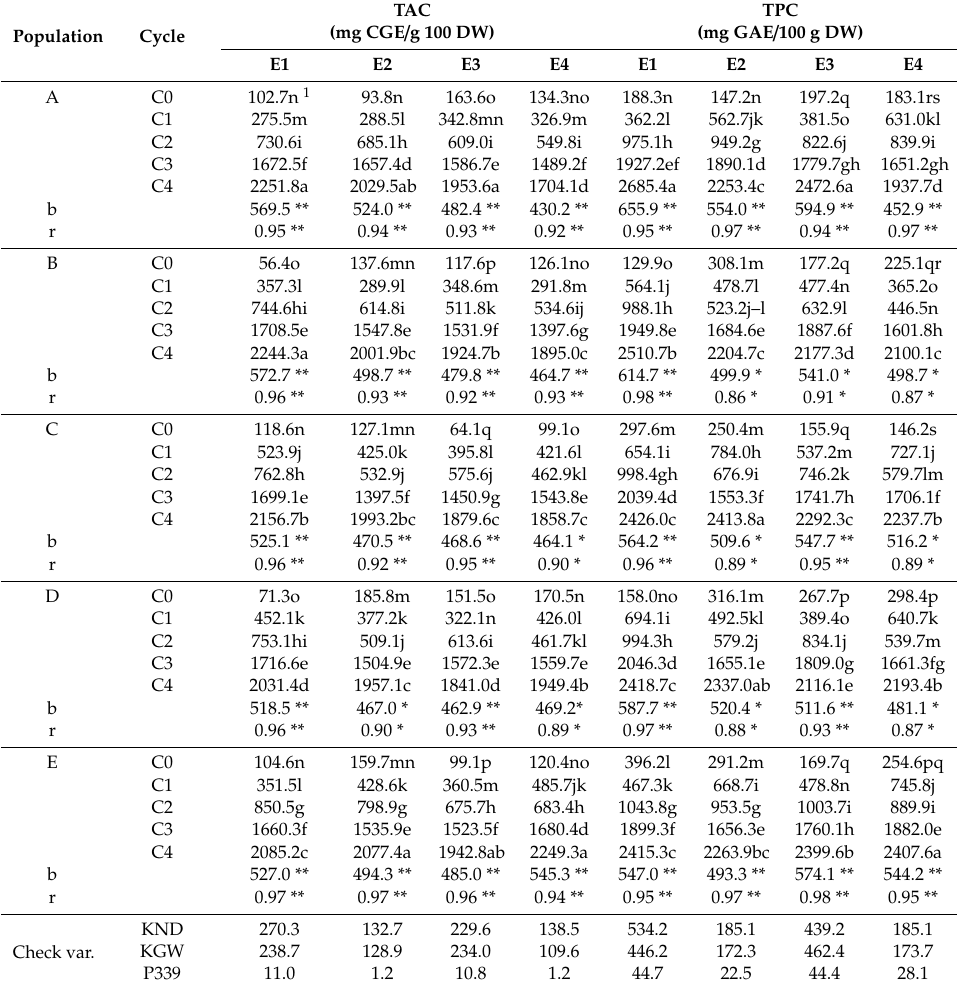
Table A5. Means for total anthocyanin content (TAC), total phenolic content (TPC) of (A–E) five populations and (C0–C4) five cycles in husk evaluated in four